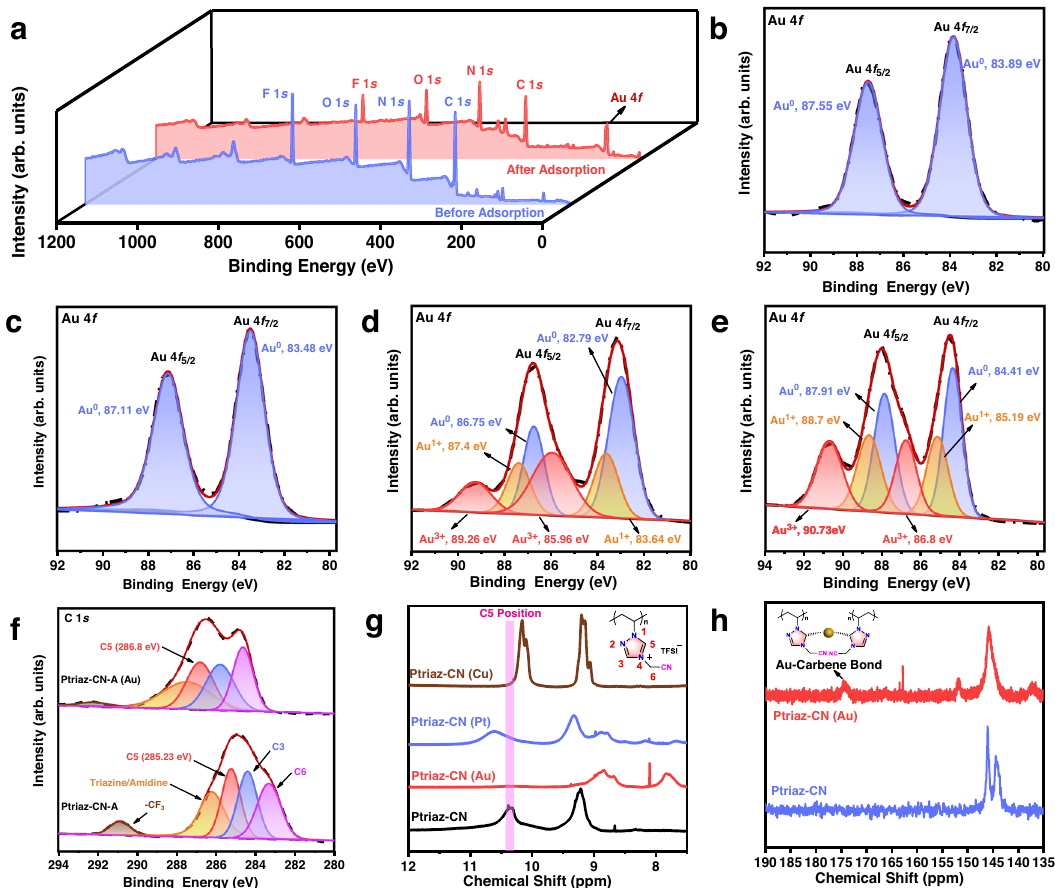
Fig. 4 | Analysis of Ptriaz-CN-A binding interactions with metal ions. a XPS pro fi le of Ptriaz-CN-A before and after Au 3+ adsorption. b – e High-resolution Au 4 f XPS spectraafteradsorptiontestsin10,100,300and 500ppmAu 3+ .The coloured shadings represent the internal integral area of different characteristic peaks. Au 0 (purple),Au 1+ (orange)andAu 3+ (red). f High-resolutionC1 s XPSspectrabeforeand